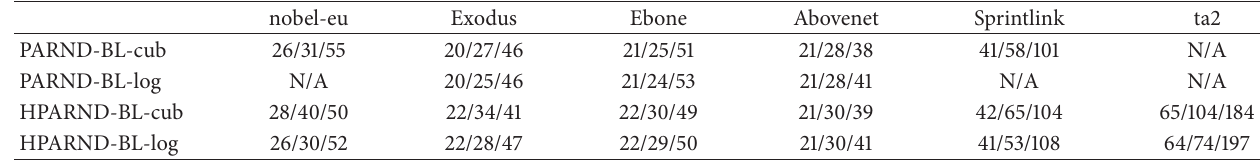
Table 5: Number of powered-on network elements (nodes/links/PICs)— 𝑃 𝐶 V = 4 kW. nobel-eu Exodus Ebone Abovenet